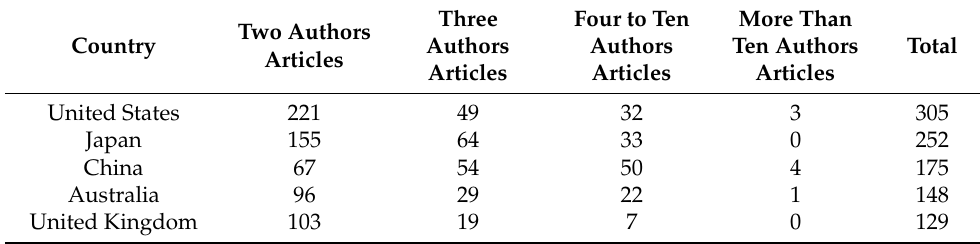
Table 3. Chiang Mai university’s international authorship pattern in science and